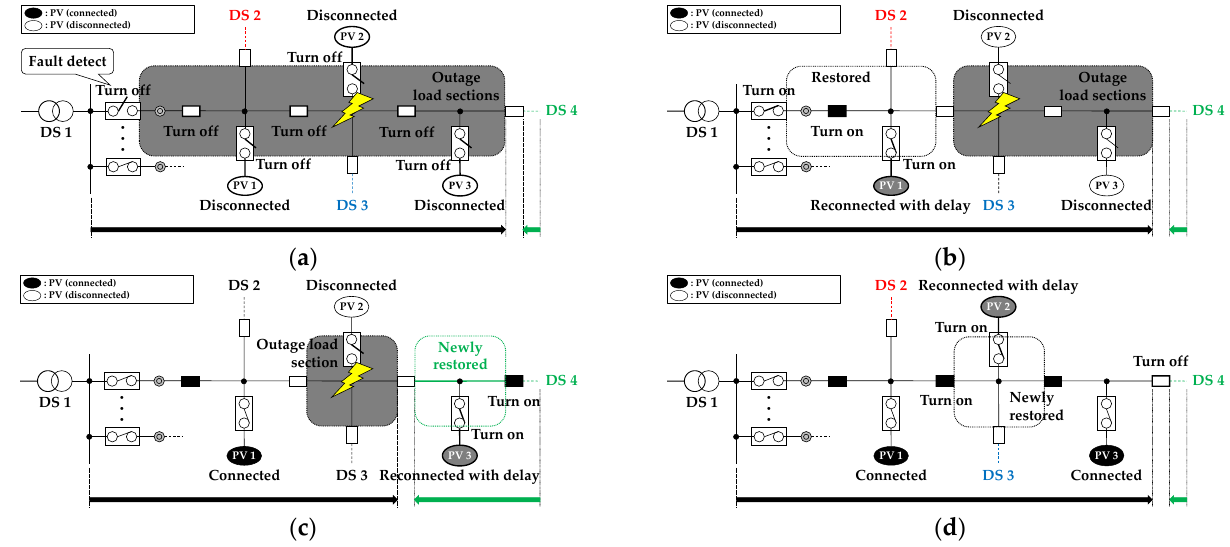
Figure 2. Service restoration procedure: ( a ) fault isolation (emergency condition); ( b ) fault identification and service reactivation (restorative phase); ( c ) service restoration by load transfer (restorative phase); ( d ) PV reconnection after fault clearing (normal condition).